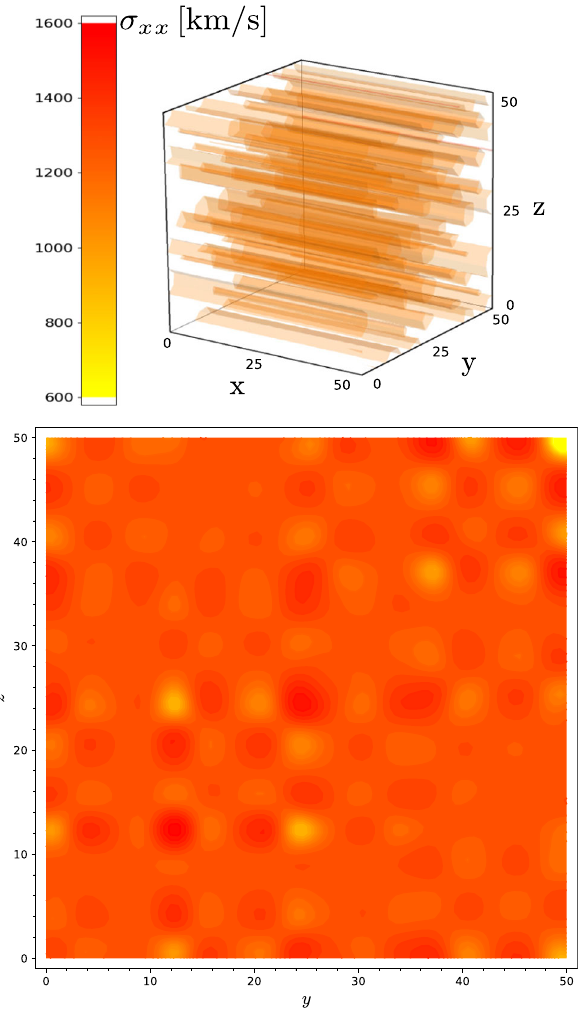
Fig. 6 The velocity dispersion element σ xx . Top panel: isosurfaces of constant σ xx within the elementary cell. Bottom: The cross-section of the σ xx profile. The colors encode the scale of the velocity dispersion in the same way as in the top panel